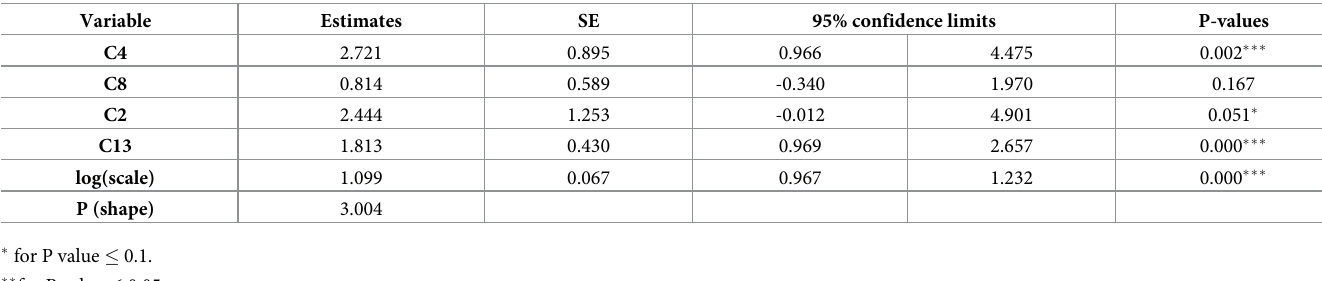
Table 6. Analysis results of rear-end